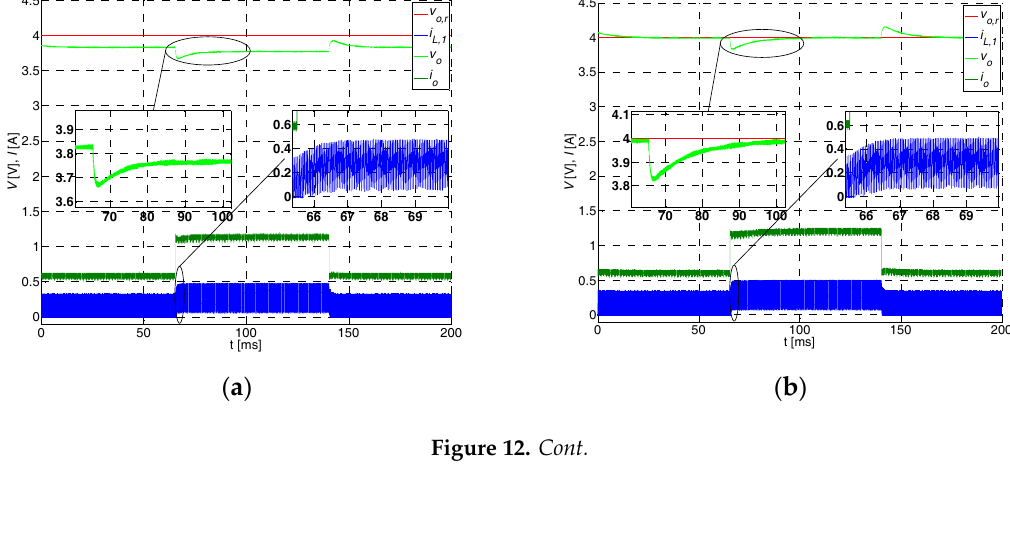
Figure 11. Output voltage response to step voltage reference change when using ( a ) P type control with i o feedforward, ( b ) PI control with i o feedforward, and ( c ) P control with i o feedforward and disturbance observer. The load was 2 Ω .